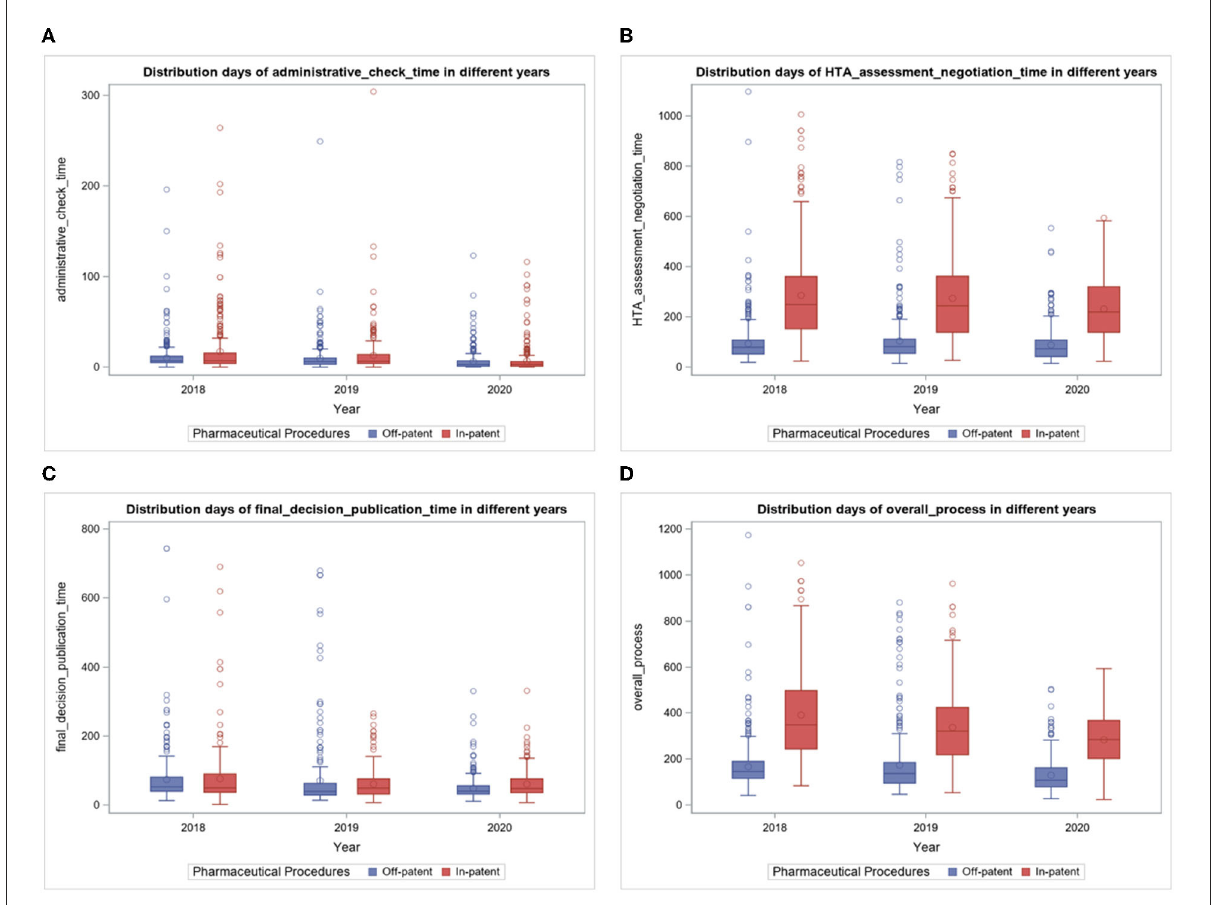
FIGURE3 (A–D) Boxplots of time days indicators per